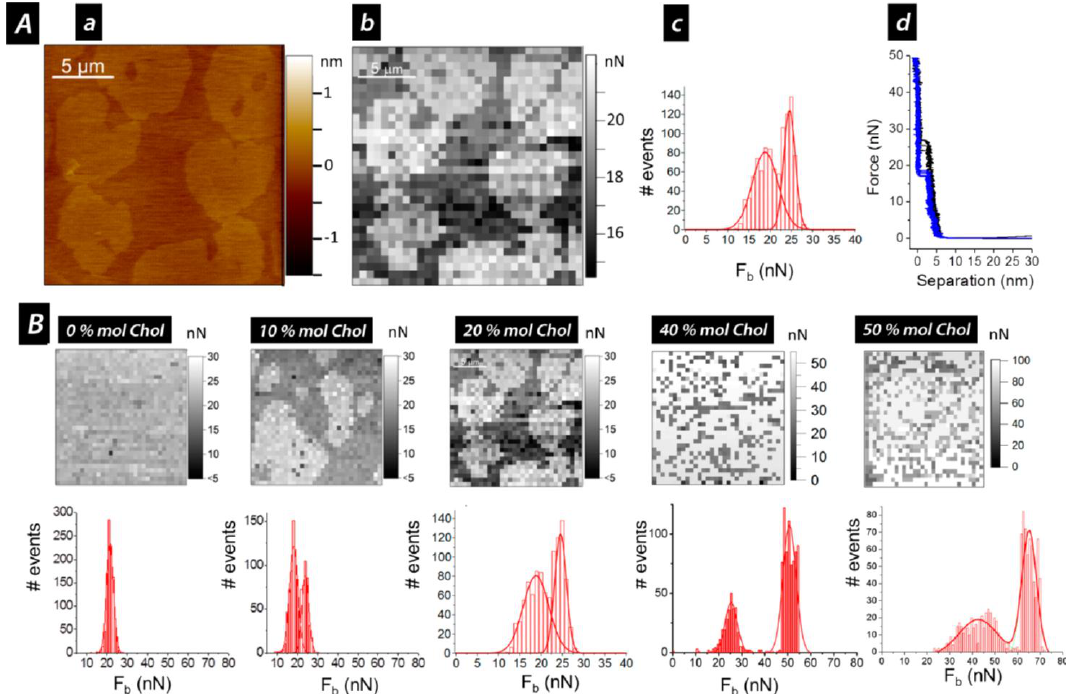
Figure 3. ( A ) DPPC:Chol SPB with 20 mol % Chol in 10 mM HEPES, 20 mM MgCl 2 , and 150 mM NaCl, pH 7.4, at 27 °C: ( a ) AC-mode AFM topographical image; ( b ) the corresponding F b map; ( c ) the corresponding F b histogram distribution; ( d ) typical approach force–separation curves of each domain (blue, domains with lower F b values; black, domains with higher F b values); ( B ) F b maps and distributions for DPPC:Chol SPBs in 10 mM HEPES, 20 mM MgCl 2 and 150 mM NaCl, pH 7.4, at 27 °C, for different Chol content: 0, 10, 20, 40, and 50 mol % Chol. Scan sizes are 10 × 10 μm 2 for 0 and 10 mol % Chol, and 20 × 20 μm 2 for 20, 40, and 50 mol % Chol. Adapted with permission from [9]. Copyright 2012 American Chemical Society.